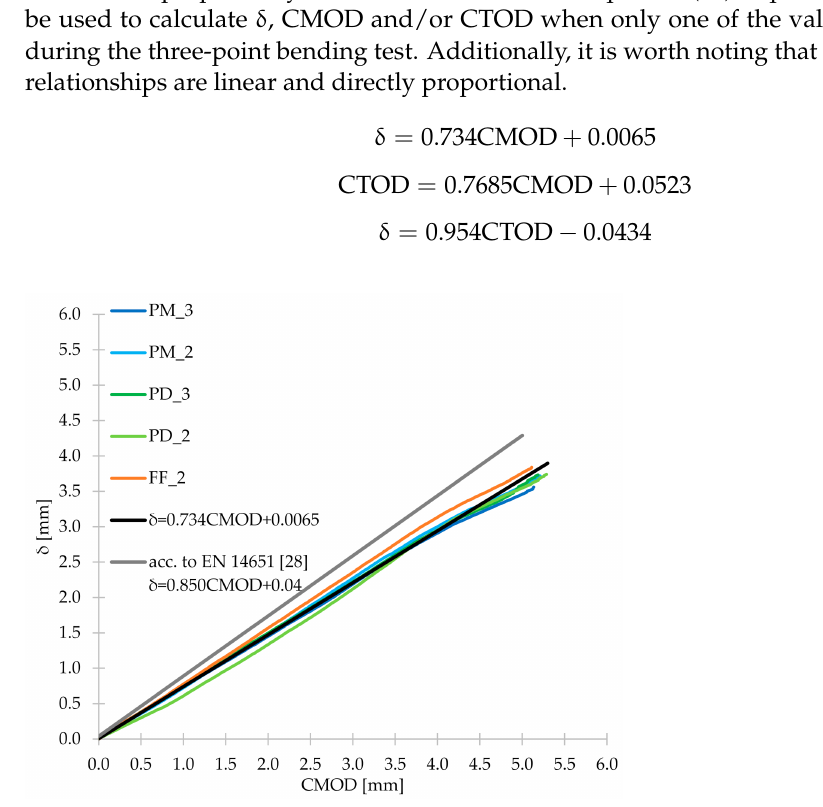
Figure 20. CMOD- δ diagram for the tested concrete mixes with the formula described in EN 14651 [28] and Equation (13) proposed by the authors.